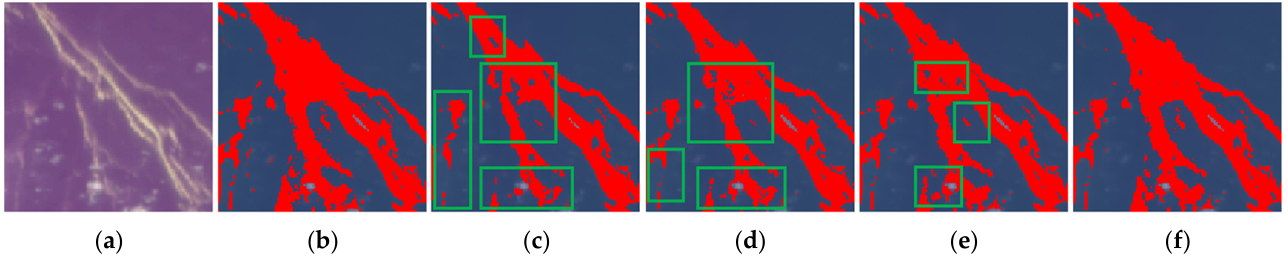
( h ) Figure 12. CZI NSB recognition result. ( a ) Ground truth; ( b ) Res UNet; ( c ) UNet; ( d ) Swin UNet; ( e ) Trans UNet; ( f ) FCN-8s; ( g ) PSPNet; ( h ) NSBRNet. 5. Discussion 5.1. Ablation Experiment As the design of NSBRNet inherits the structure of UNet [26], this section conducts ablation experiments using UNet as the baseline model to evaluate the in fl uence of ICB and SAB on the performance of NSB recognition. The same computing resources and in- put parameters were used in the ablation experiment.